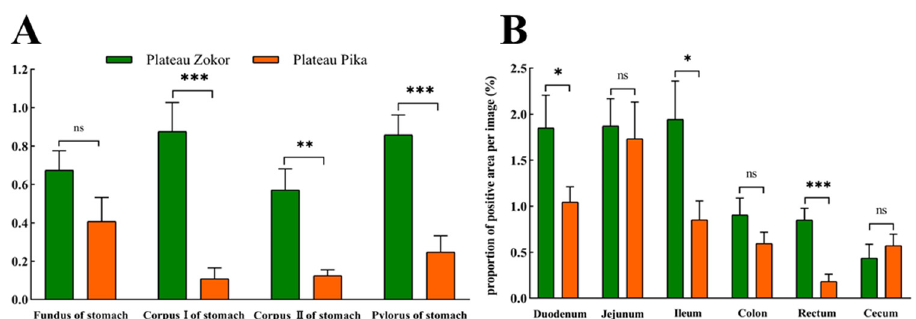
Figure 7. The difference in positive expression levels for 5-HT-immunoreactive cells in the gastro- intestinal organs of the plateau zokor and plateau pika. ( A ) In the stomach; ( B ) in the intestinal tract. *, **, and *** indicate significant interspecific difference ( p < 0.05, p < 0.01, p < 0.001); ns indicates an insignificant interspecific difference.